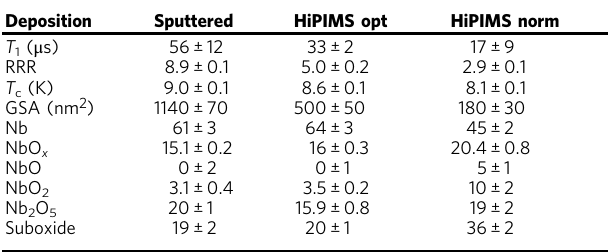
Fig. 1 Transmon qubit design and performance. a False color optical image of a representative transmon qubit from our study. Niobium regions include the center-pin of the coplanar waveguide resonator (green), the transmon capacitor pads (purple), and the ground plane (gray). The aluminum Josephson junction is shown in white. Black areas indicate where the metal has been etched away, and the sapphire substrate is exposed. b Effective circuit diagram of a transmon qubit coupled to a resonator. Each circuit element is schematically colored as in ( a ). The resonator is comprised of a center-pin coupled to ground via a capacitor ( C r ) and an inductor ( L r ). E J and C refer to the Josephson energy and the capacitance of the qubit respectively. The qubit is capacitively coupled to the center-pin of the resonator ( C c ) and to ground ( C g ). c Measured relaxation times ( T 1 ) for three rounds of devices fabricated with sputtered (purple circles), HiPIMS optimized (blue diamonds), and HiPIMS normal (green squares) niobium fi lms, for a total of nine devices. Error bars indicate standard deviation across all T 1 measurements taken on a particular device. Table 1 Summary of the main parameters extracted from qubit and thin fi lm